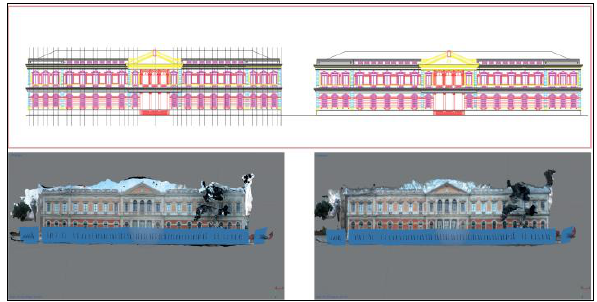
Figure 3 Analysis of the main facade modules based on photo- plane from